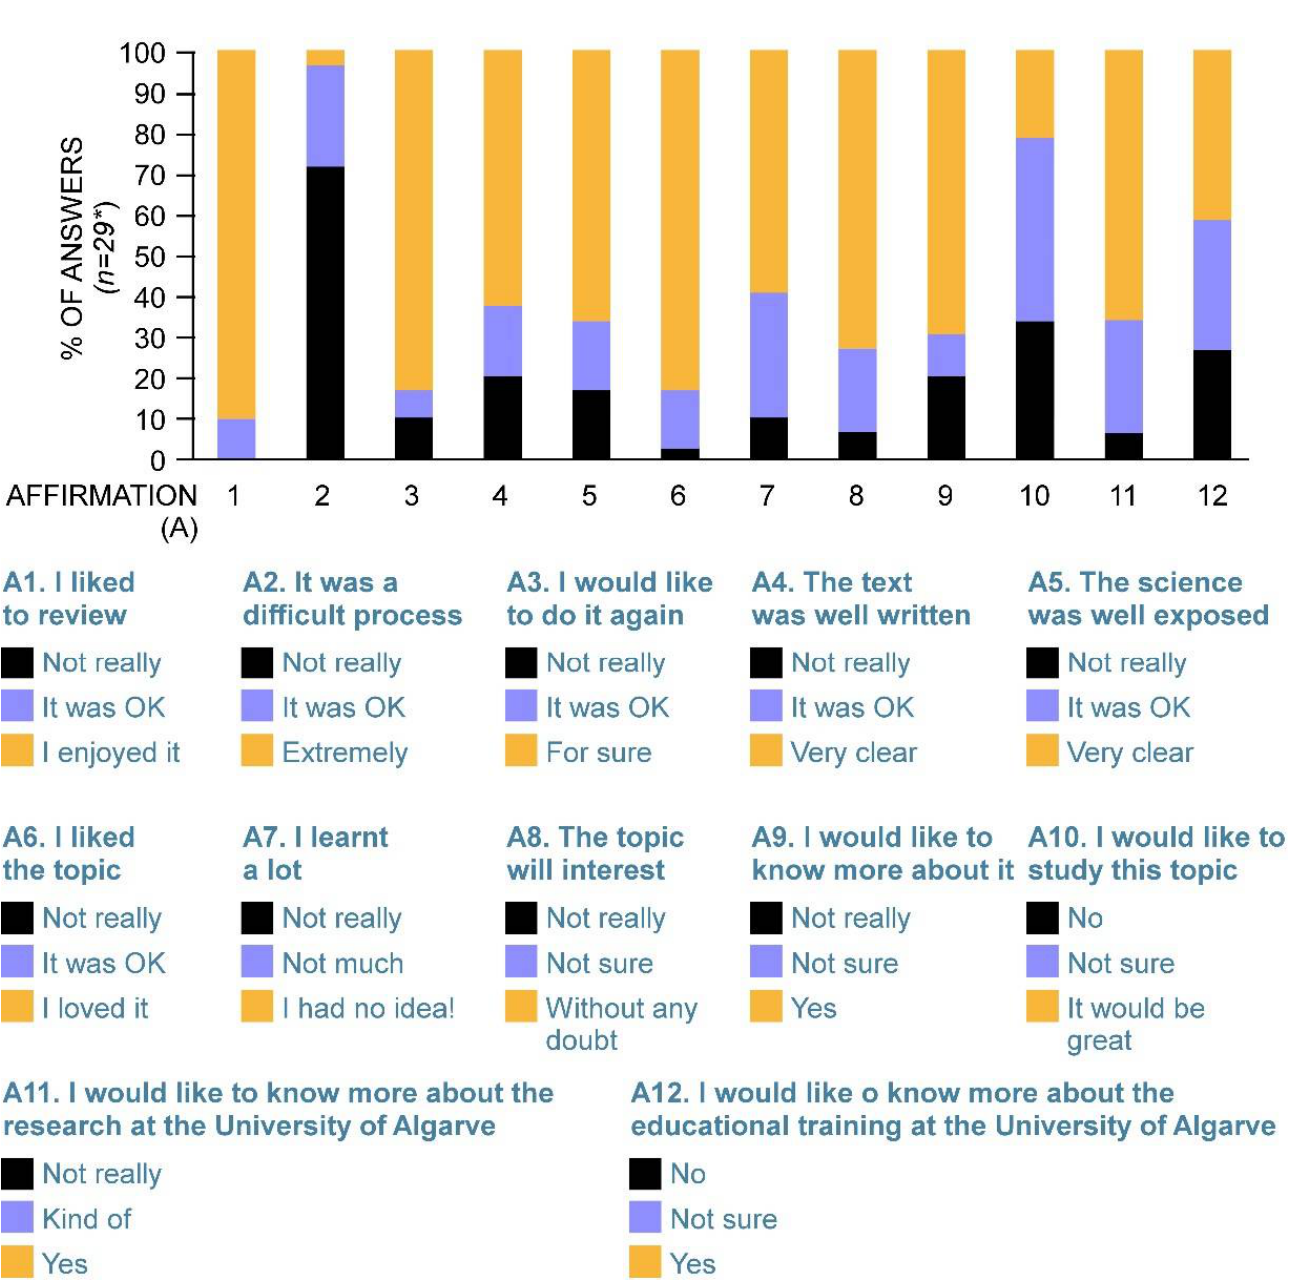
Figure 2. Graphical representation of the results from the inquiry after the review process. The results presented in Table 1 have been re-organized in such a way that answers 1 and 2 in one hand, and the answers 4 and 5 to in the other hand, which reflect nuances of the same answer were combined (*), are represented by black and orange histograms, respectively. The neutral answer 3 is indicated by blue histograms. The histograms represent the percentage (%) of answers. The summary of each affirmation and answers (A1 to A12) from the inquiry are presented below the graph.